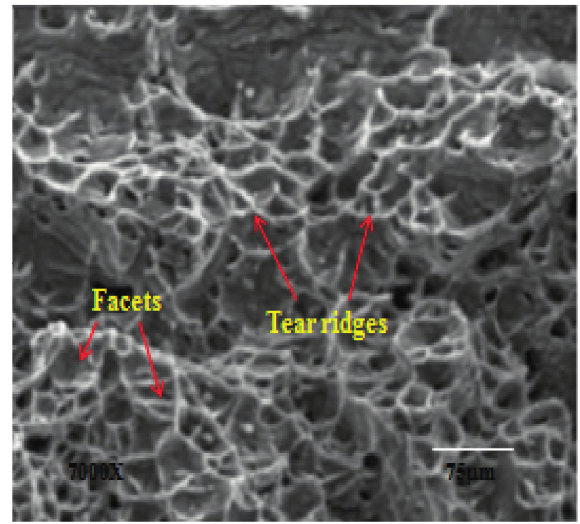
Figure 7: Fractography images of the starting